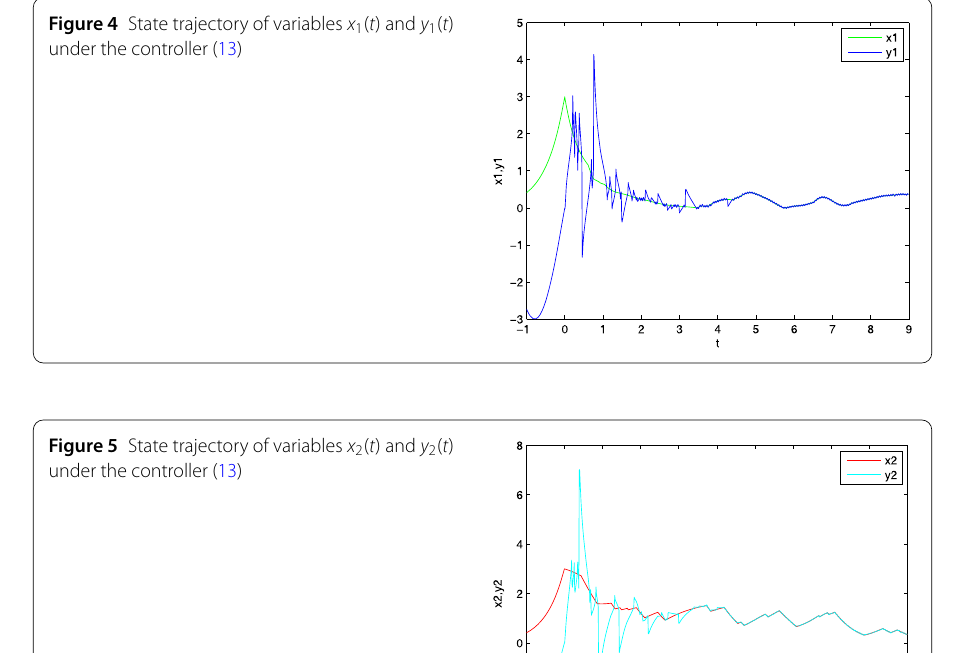
Figure 5 State trajectory of variables x 2 ( t ) and y 2 ( t ) under the controller (13)